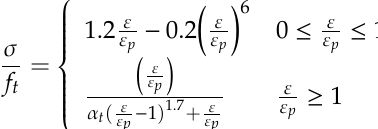
( d ) Figure 19. Comparison of load–deflection curves of composite slabs at mid-span between tests and FEA. ( a ) SCLC-B-1, ( b ) SCRLC30-B-1, ( c ) SCLC-B-2, ( d ) SCRLC30-B-2.